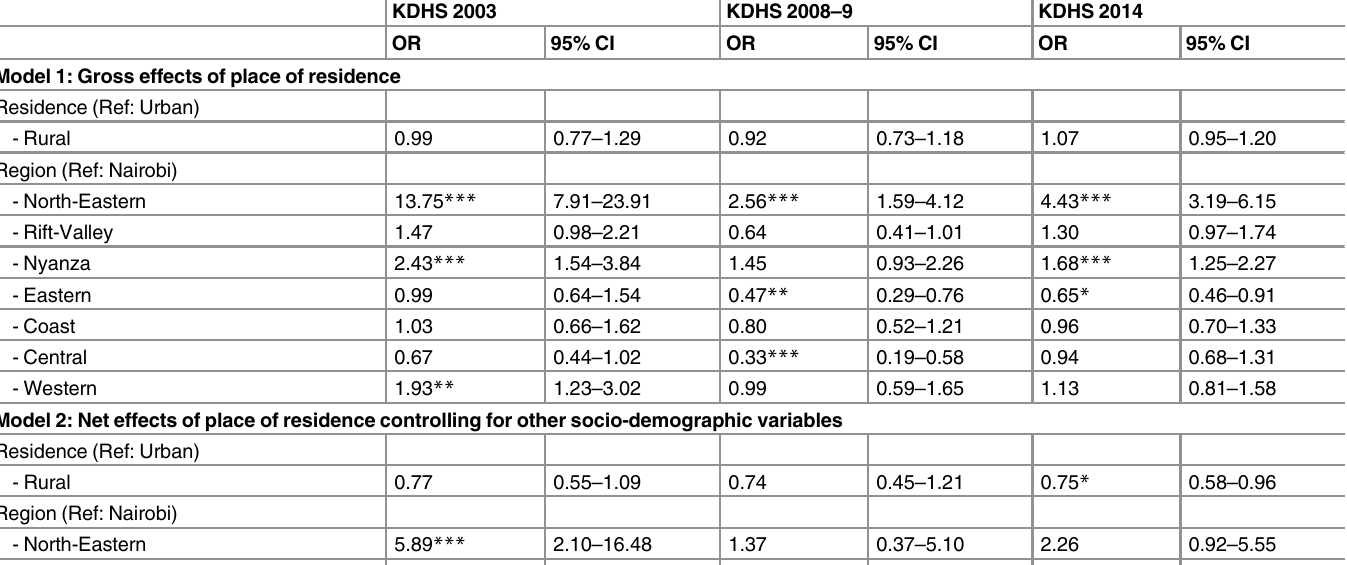
Table 3. Correlates of complxete